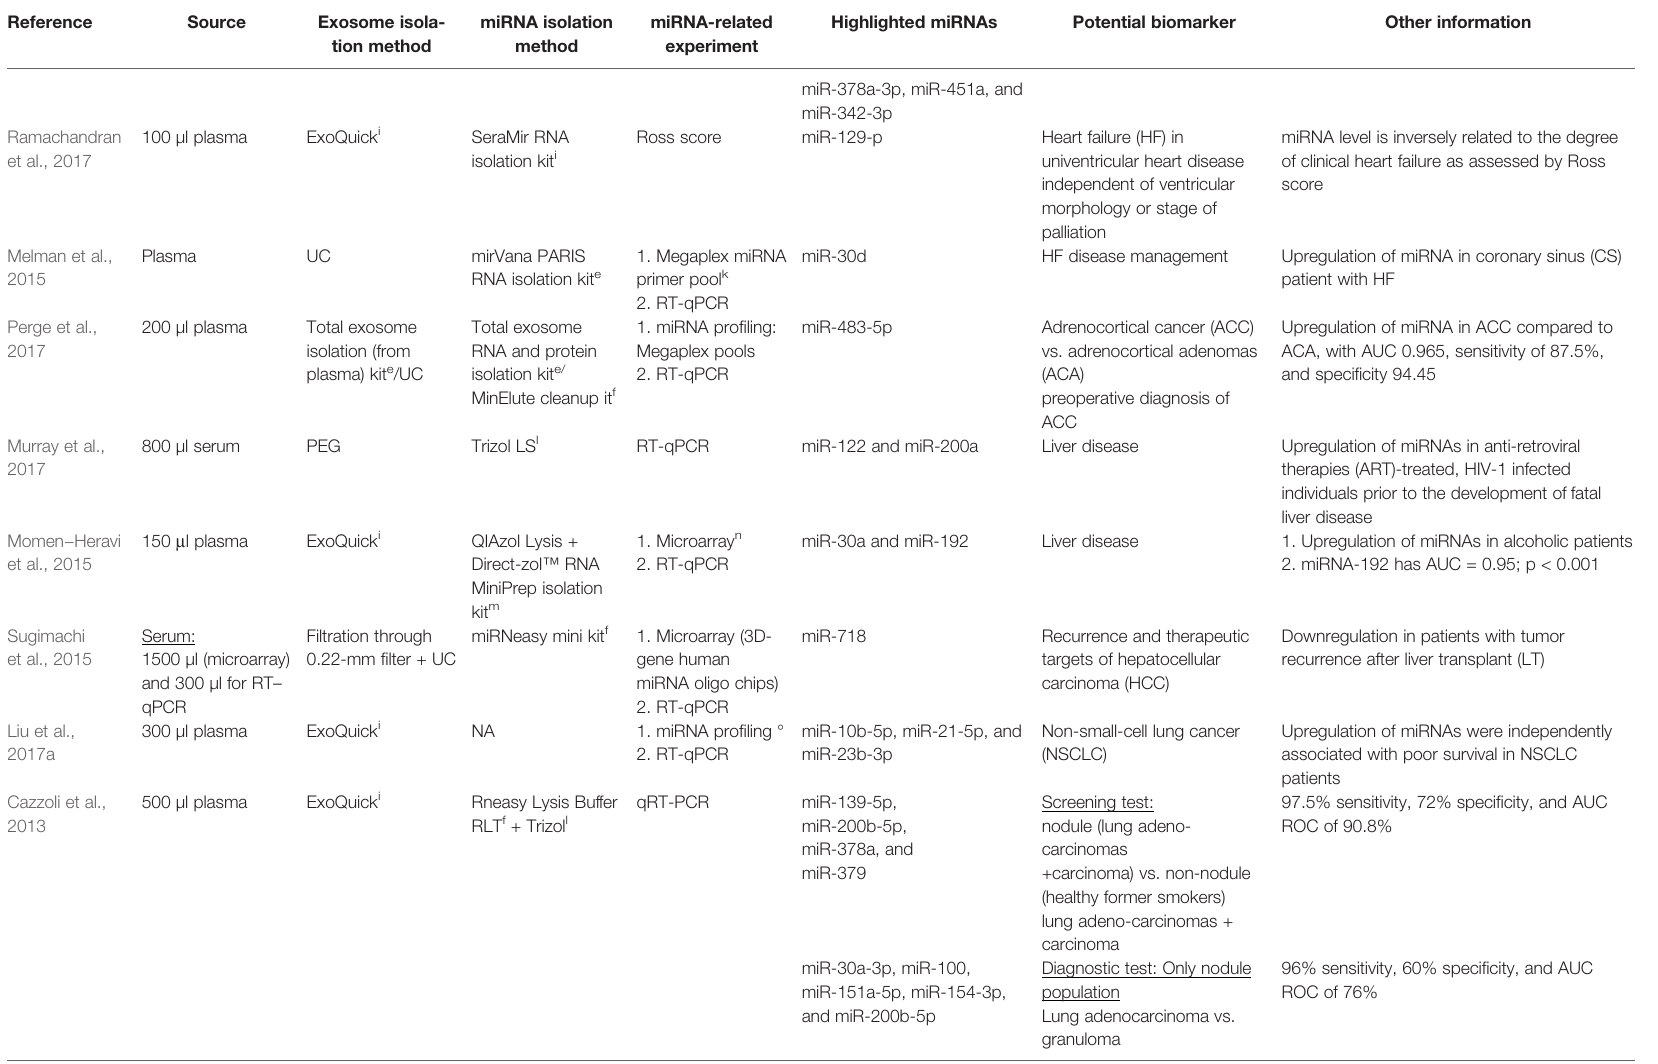
Lung adenocarcinoma vs.